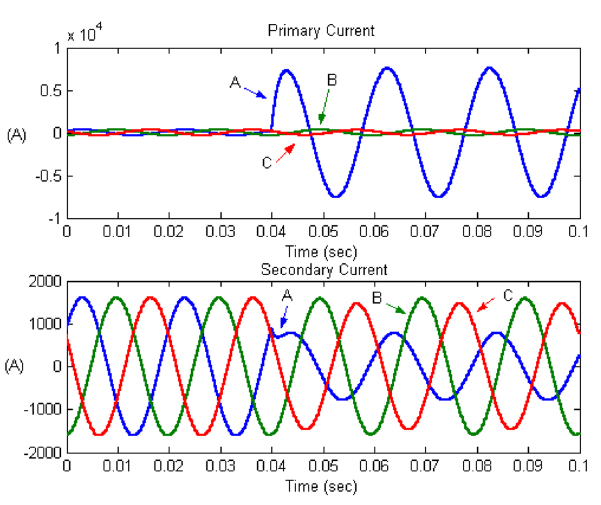
Figure 5. Primary and secondary currents under phase A winding-to-ground fault occurrence on the high- voltage winding at 10% of the